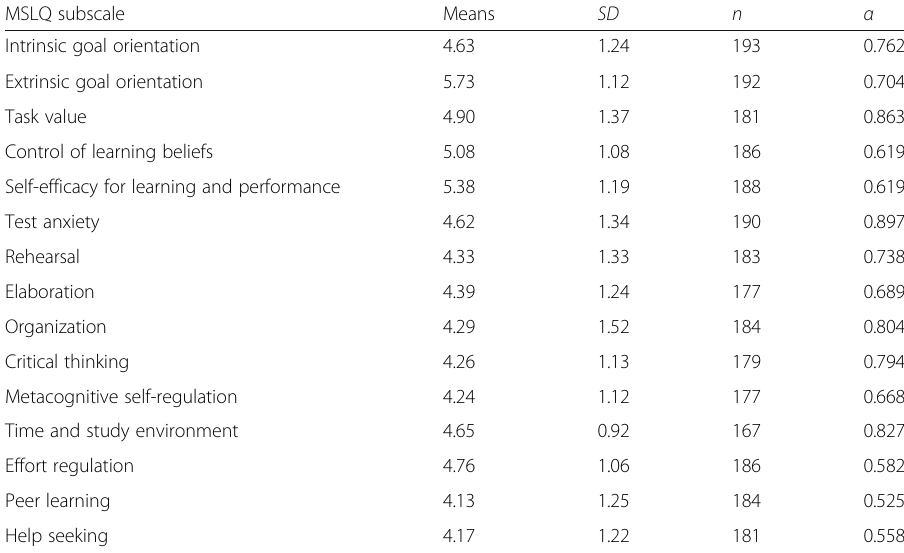
Table 2 Means, SD, and internal consistency (Cronbach ’ s Alpha) coefficients MSLQ subscale